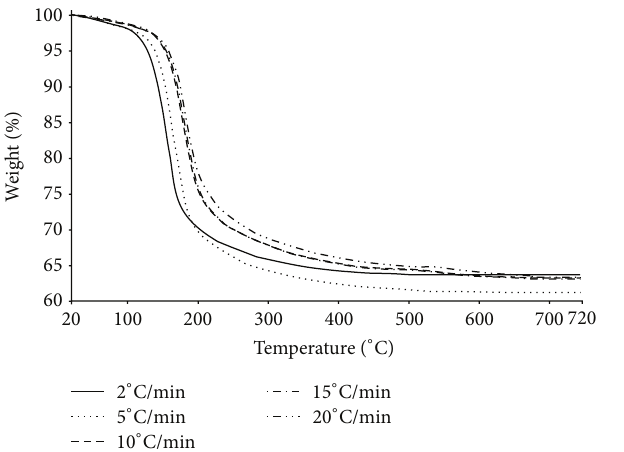
Figure 7: TG curve of synthesized pure mcallisterite.